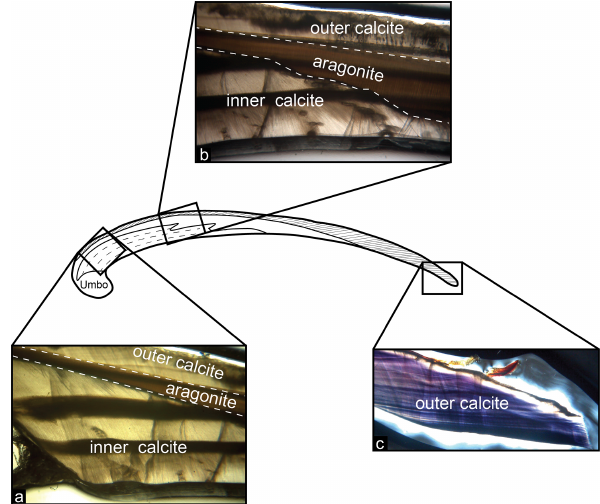
Figure 3. Shell structure and mineralogical layering in M. californi- anus . (a) Photo taken under light microscope focused at the region of interest showing the three mineralogical layers. Dashed lines in- dicate boundaries between inner calcite, aragonite, and outer cal- cite layers. (b) Photo taken towards the middle of the cross section showing that the inner calcite layer tapers to an end. (c) Photo taken at the posterior margin of the cross section at the commissure, where the outer calcite layer is the only layer present.